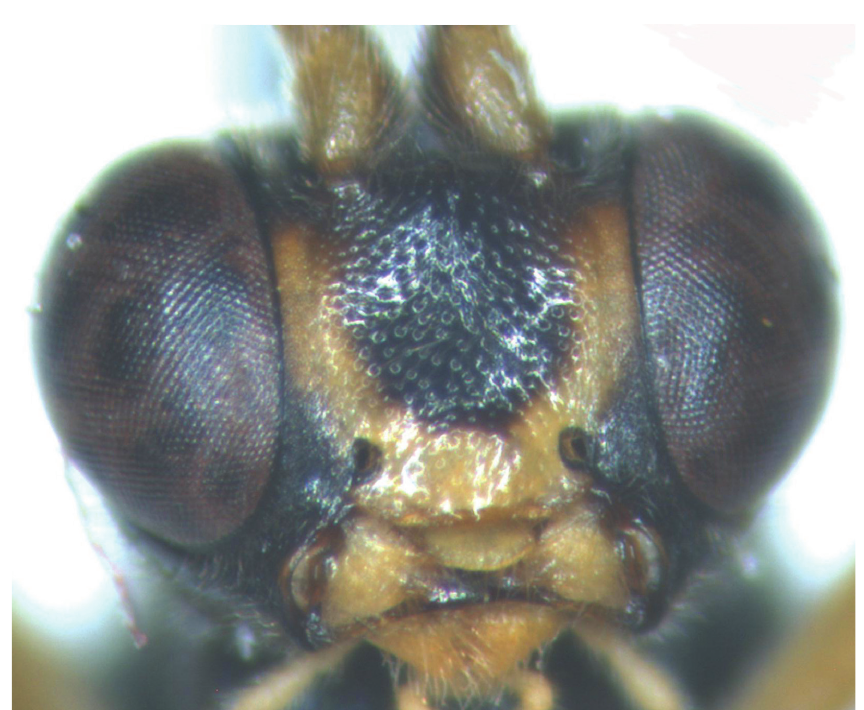
Figure 10. Face of Bicurta